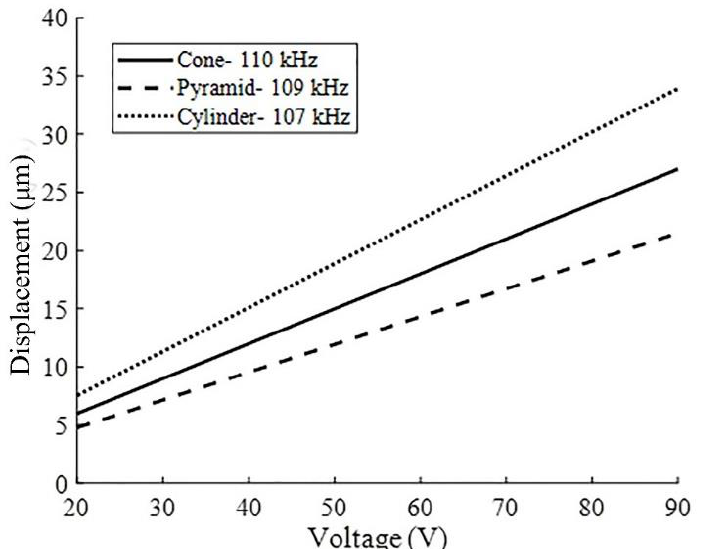
Figure 8. Displacement against the voltage amplitude.